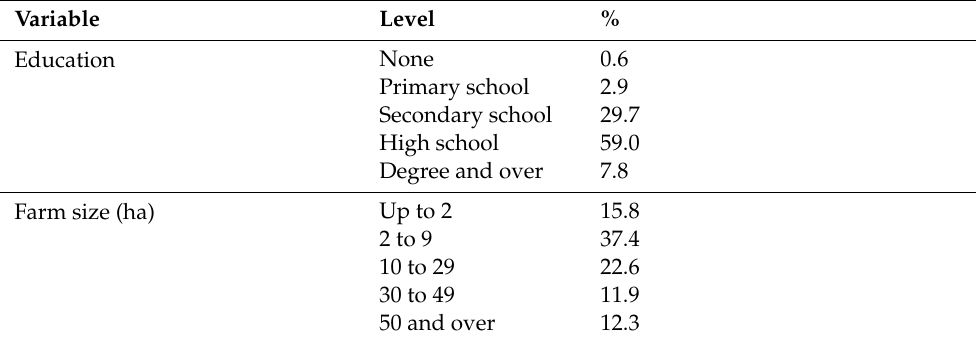
Table 1. Descriptive statistics for the variables of